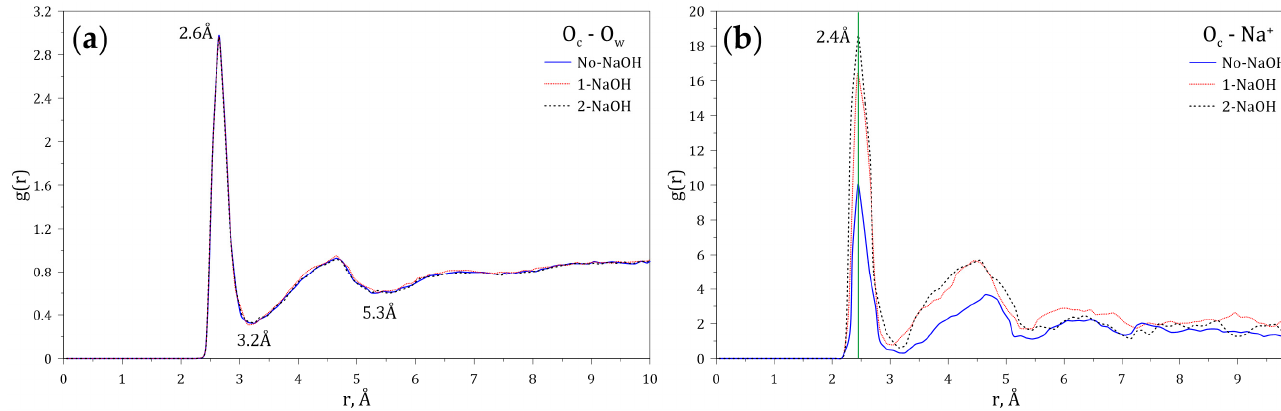
Figure 4. Radial distribution functions (g(r)) of ( a ) O w and ( b ) Na + interacting with the carboxylate group of the HPAM at varying concentrations of NaOH.